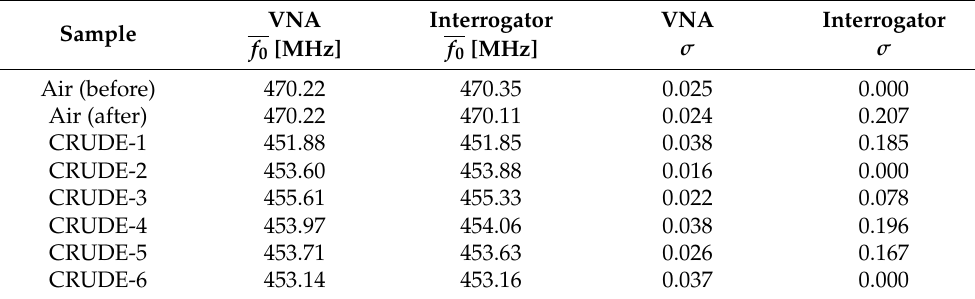
Table 1. List of the measured resonant frequencies and standard deviation σ = | f 0 − f 0 | 2 / N for the same sensor driven by the VNA and the implemented interrogator for different crude